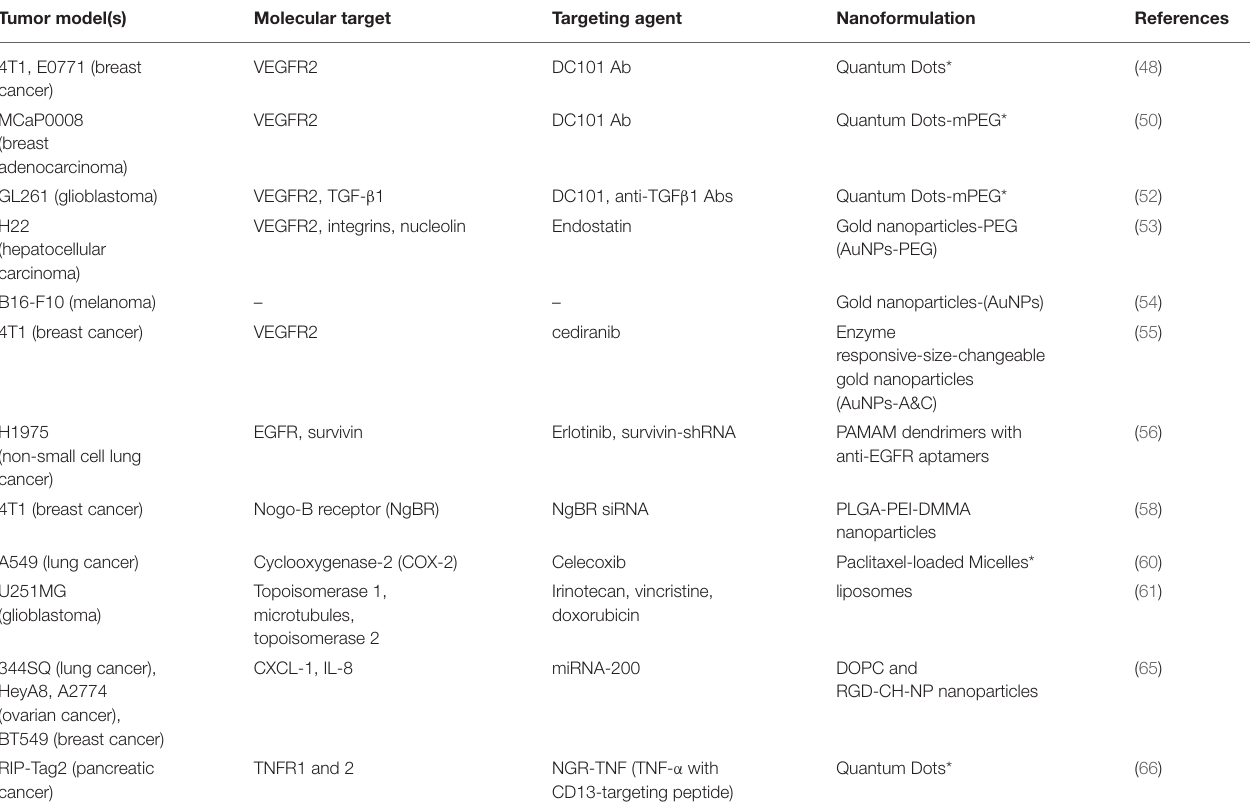
TABLE 1 | Table summarizing the data regarding vascular normalization, including tumor models, molecular targets, targeting agents, and nanoformulations. Tumor